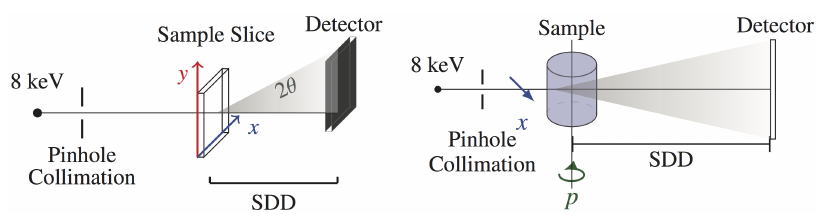
Fig 1. Schematic of the imaging setup for planar SAXS (left) and SAXS-CT